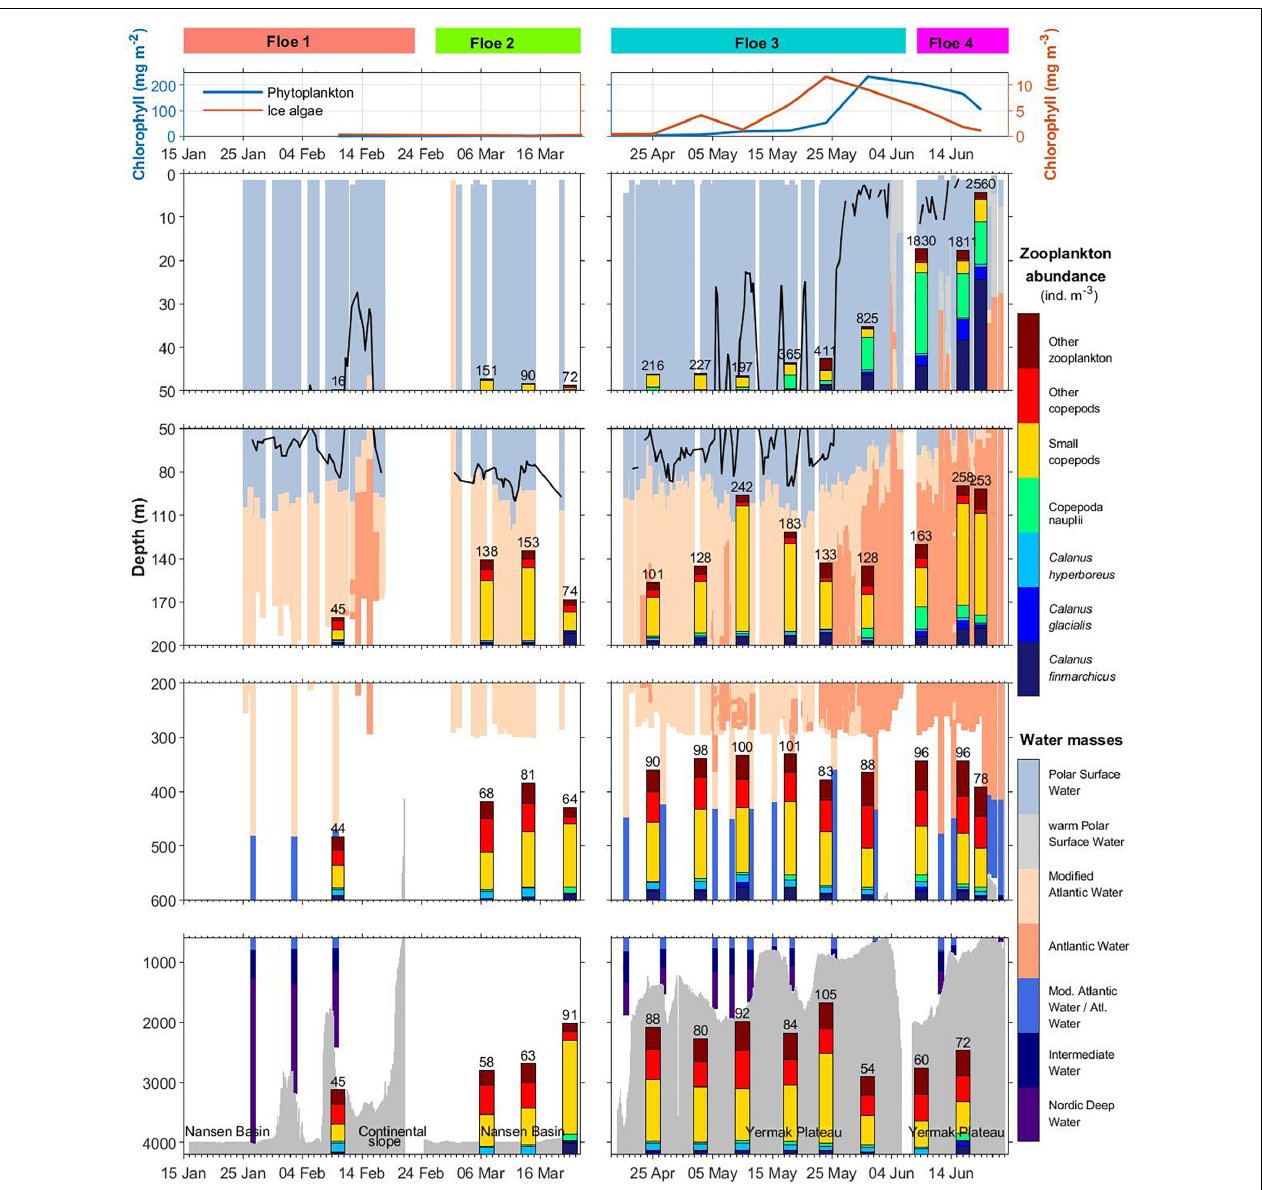
FIGURE 2 | Chlorophyll a standing stock of phytoplankton (mg m − 2 ) and ice algae in the bottom 10 cm of sea ice (mg m − 3 ) during the N-ICE2015 drift (upper panels). Vertical distribution of water masses and abundance of key zooplankton species at different depth ranges: 0–50 m, 50–200 m, 200–600 m, and 600 m to deepest sample. Water-masses are labelled by colour: Atlantic Water (AW), Modified Atlantic Water (MAW), Polar Surface Water (PSW), warm Polar Surface Water (PSWw), Intermediate Water (IW) and Nordic Deep Water (NDW) following definitions by Rudels et al. (2000). Lack of colour indicates a lack of hydrography data, most notably between drifts and at depth. Overlain the water masses colour scale is a contour of the mixed-layer depth (black line). Zooplankton abundance axes are scaled to fit each figure, for better discrimination between groups, with the sum of abundance (ind. m − 3 ) indicated above bars. Seafloor depth indicating topographic features is shaded in